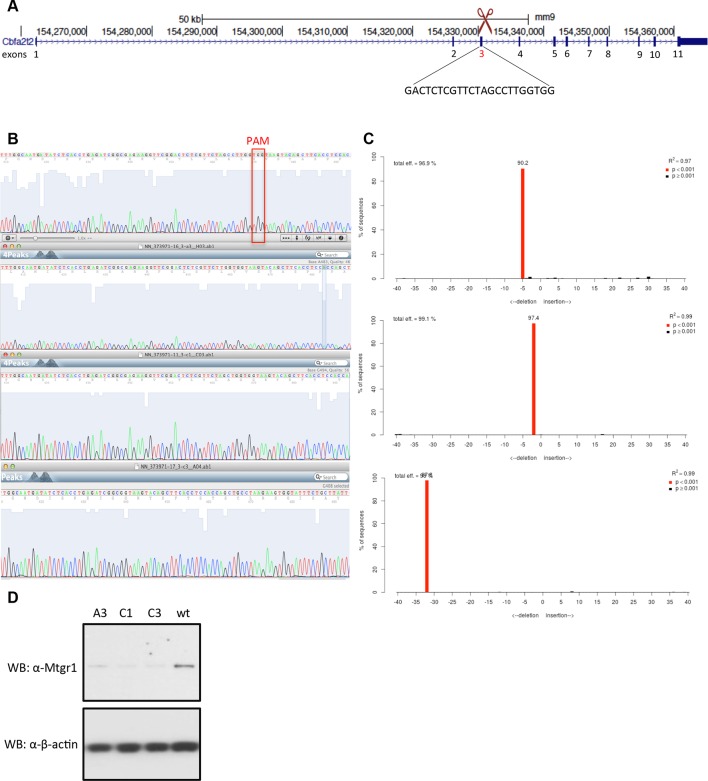
Generation of Mtgr1-null line in Stella:GFP mESCs using CRISPR-Cas9 system.(A) Schematic of the Mtgr1 gene and sequence of the guide RNA (http://crispr.mit.edu/). (B) Genomic and cDNA were extracted and chromatograms of the wt (top), mutant A3 line (clone 1), mutant C1 line (clone 2), and mutant C3 line (clone 3) are shown. (C) Indel spectrum centered around the PAM sequence was performed using software TIDE (http://tide.nki.nl/). Clones A3, C1, and C3 are shown, they all produce aberrant transcript. (D) Western blotting of the whole cell lysate from the wt, A3, C1 and C3 mESC Stella:GFP line. CRISPR, clustered regularly interspaced short palindromic repeat; GFP, green fluorescent protein; PAM, protospacer adjacent motif; mESCs, mouse embryonic stem cells; Mtgr1, myeloid translocation gene related 1; wt, wild type.